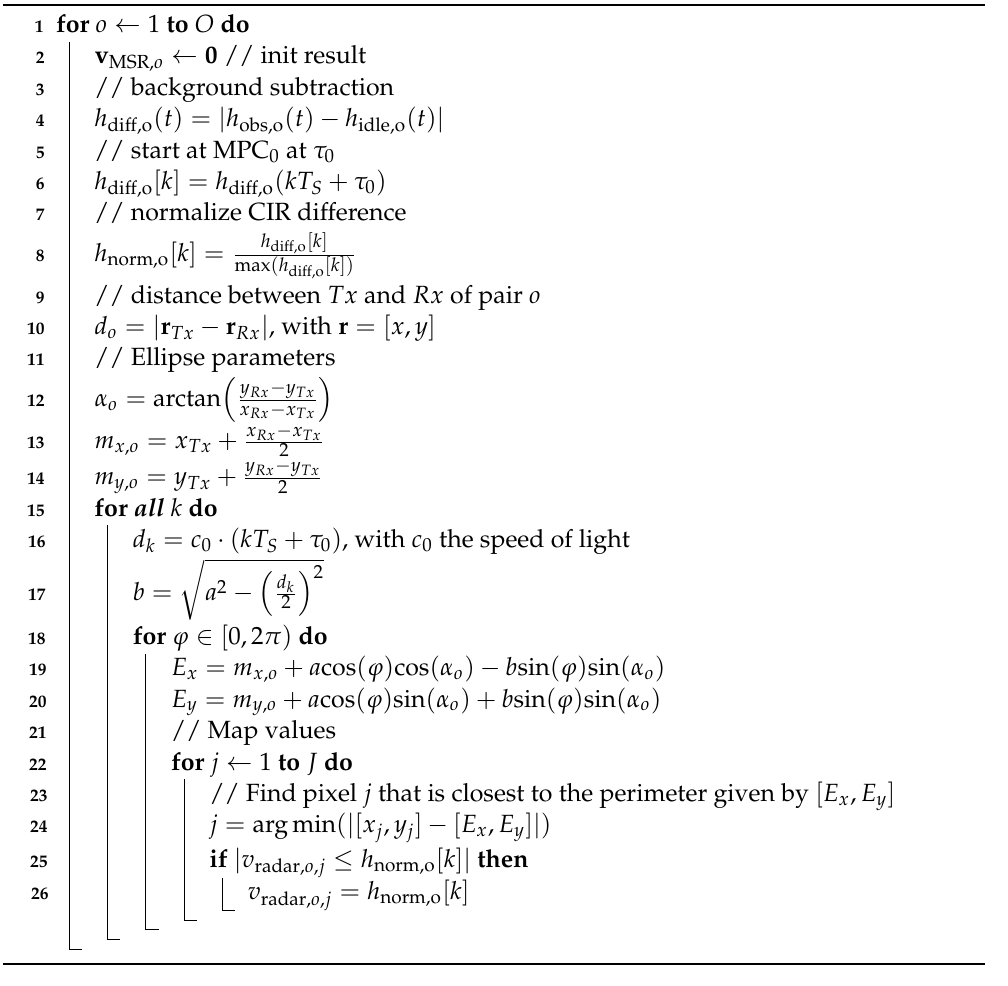
Algorithm 1: Pseudo-code for multi-static radar heat map calculation